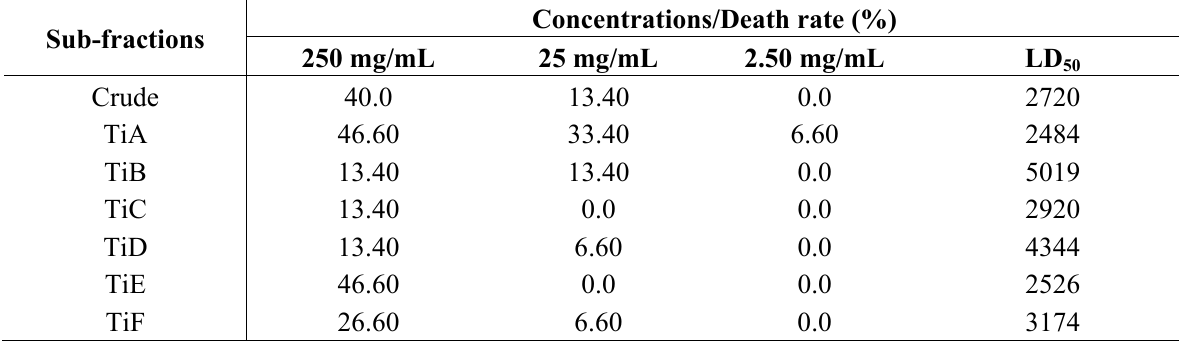
Table 4. Lethality of T. indica fractions on chicken